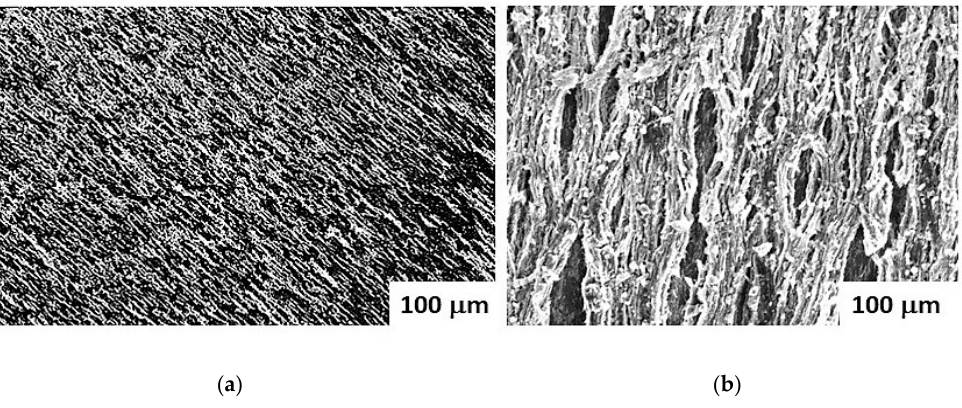
Figure 6. SEM micrograph for core–shell fibers of sample A assembled in (a) a uniform magnetic field and (b) in a non-uniform field produced by a permanent magnet.